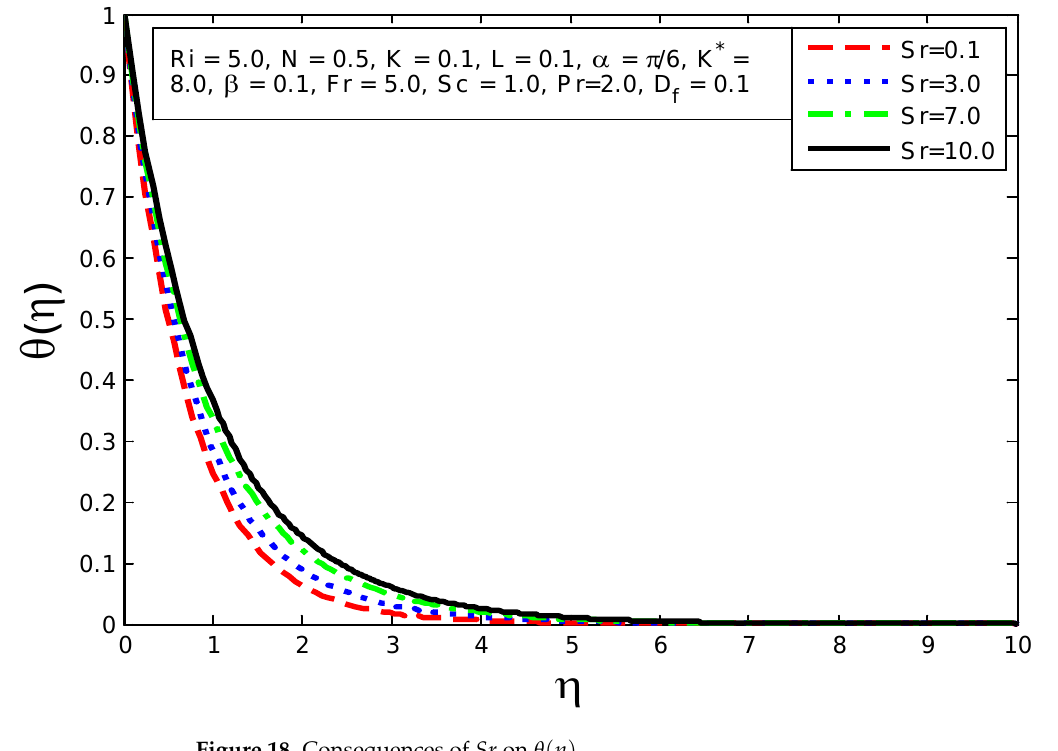
on . Figure 18. Consequences of Sr on θ ( η ) . 𝑆𝑆𝑆𝑆 𝜃𝜃 ( 𝜂𝜂 )